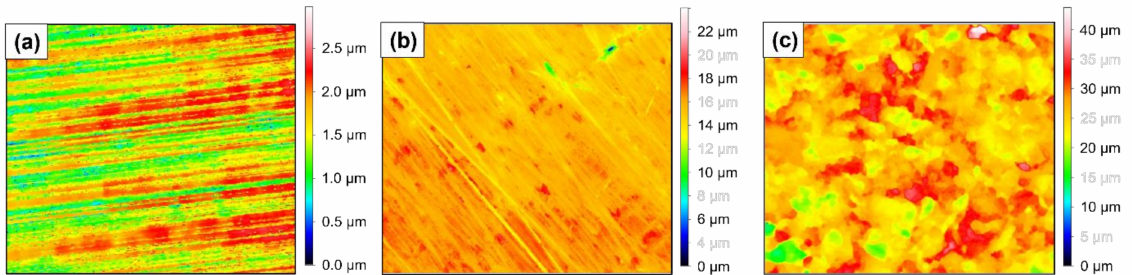
Figure 4. Optical profilometry’s 3D profiles of the aluminium: ( a ) without any surface treatment, ( b ) after been polished by SP, and ( c ) after the GB